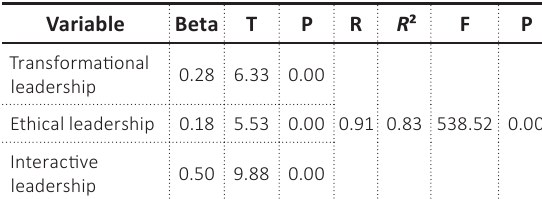
Table 10. The results of applying the